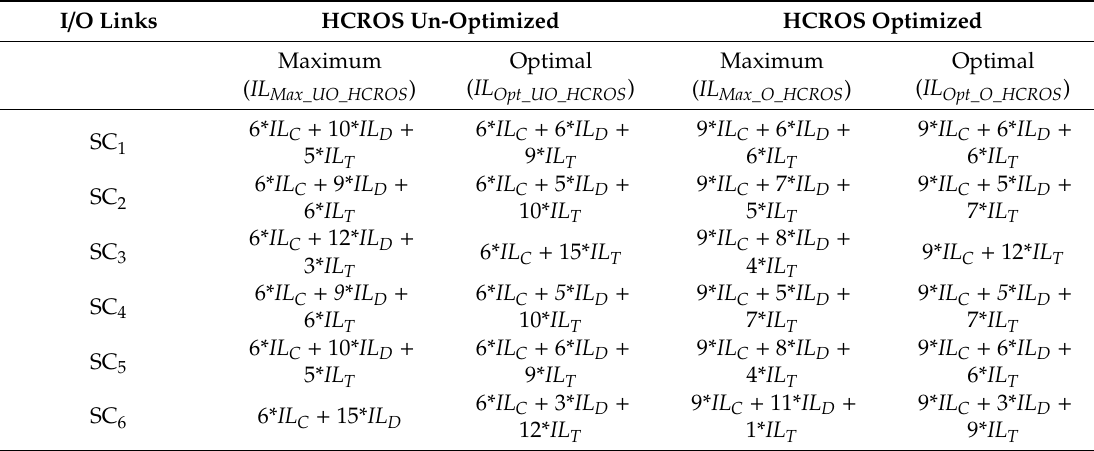
Figure 16. Optimal switching combinations of I / O links in optimized HCROS. ( a ) I / O link SC 1 with 6 OSEs in drop / bar state. ( b ) I / O link SC 2 with 5 OSEs in drop / bar state. ( c ) I / O link SC 3 with all OSEs in through / cross state. ( d ) I / O link SC 4 with 5 OSEs in drop / bar state. ( e ) I / O link SC 5 with 6 OSEs in drop / bar state. ( f ) I / O link SC 6 with 3 OSEs in drop / bar state. Table 12. Insertion loss of OSEs in